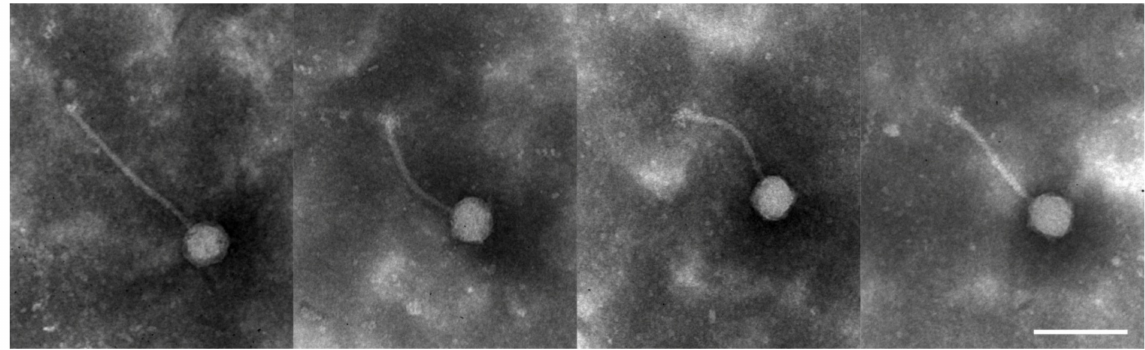
Figure 1. Transmission electron microscopy of Enterococcus phage VEsP-1. Scale bar, 100 nm. As a result of DNA sequencing, 1,399,584 paired-end reads were obtained. The viral genomic sequence was assembled de novo into a single contig with 60 × coverage and was manually corrected. The length of the genome was 39,221 bp with the GC content at 35.1%. The genome contained 63 protein-coding genes and 1 tRNA